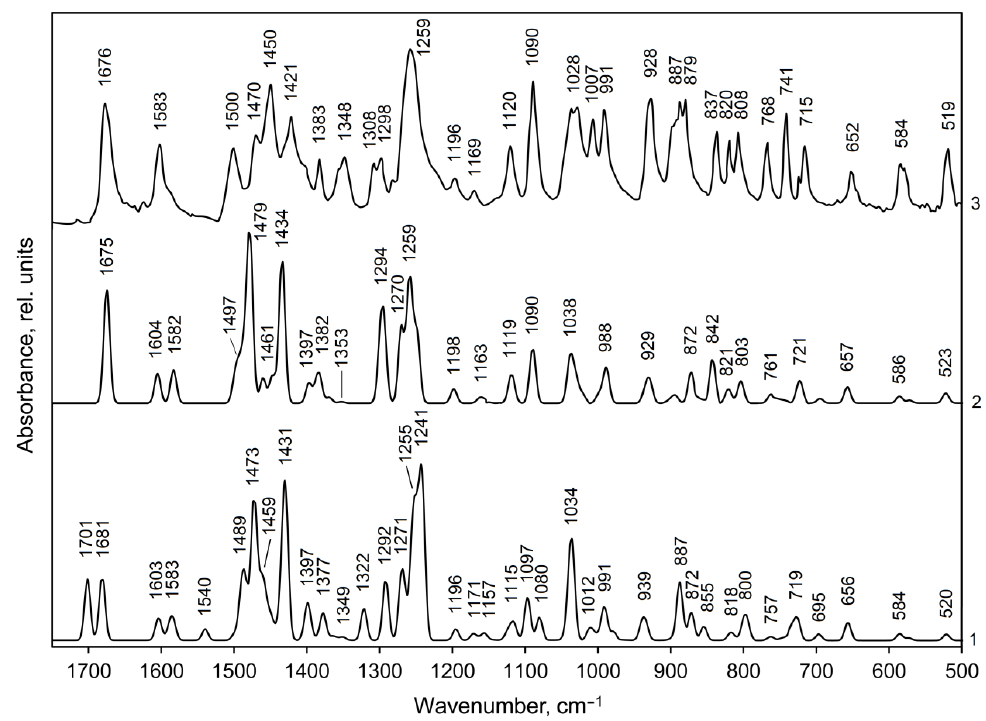
Figure 6. Calculated (curves 1, 2) and experimental (curve 3, [48]) IR spectra of methylone hydrochloride in the 1750 – 500 cm − 1 range: curve 1 — IR spectrum for dimer 1, curve 2 — IR spectrum for dimer 2. Line half-width is 10 cm − 1 .